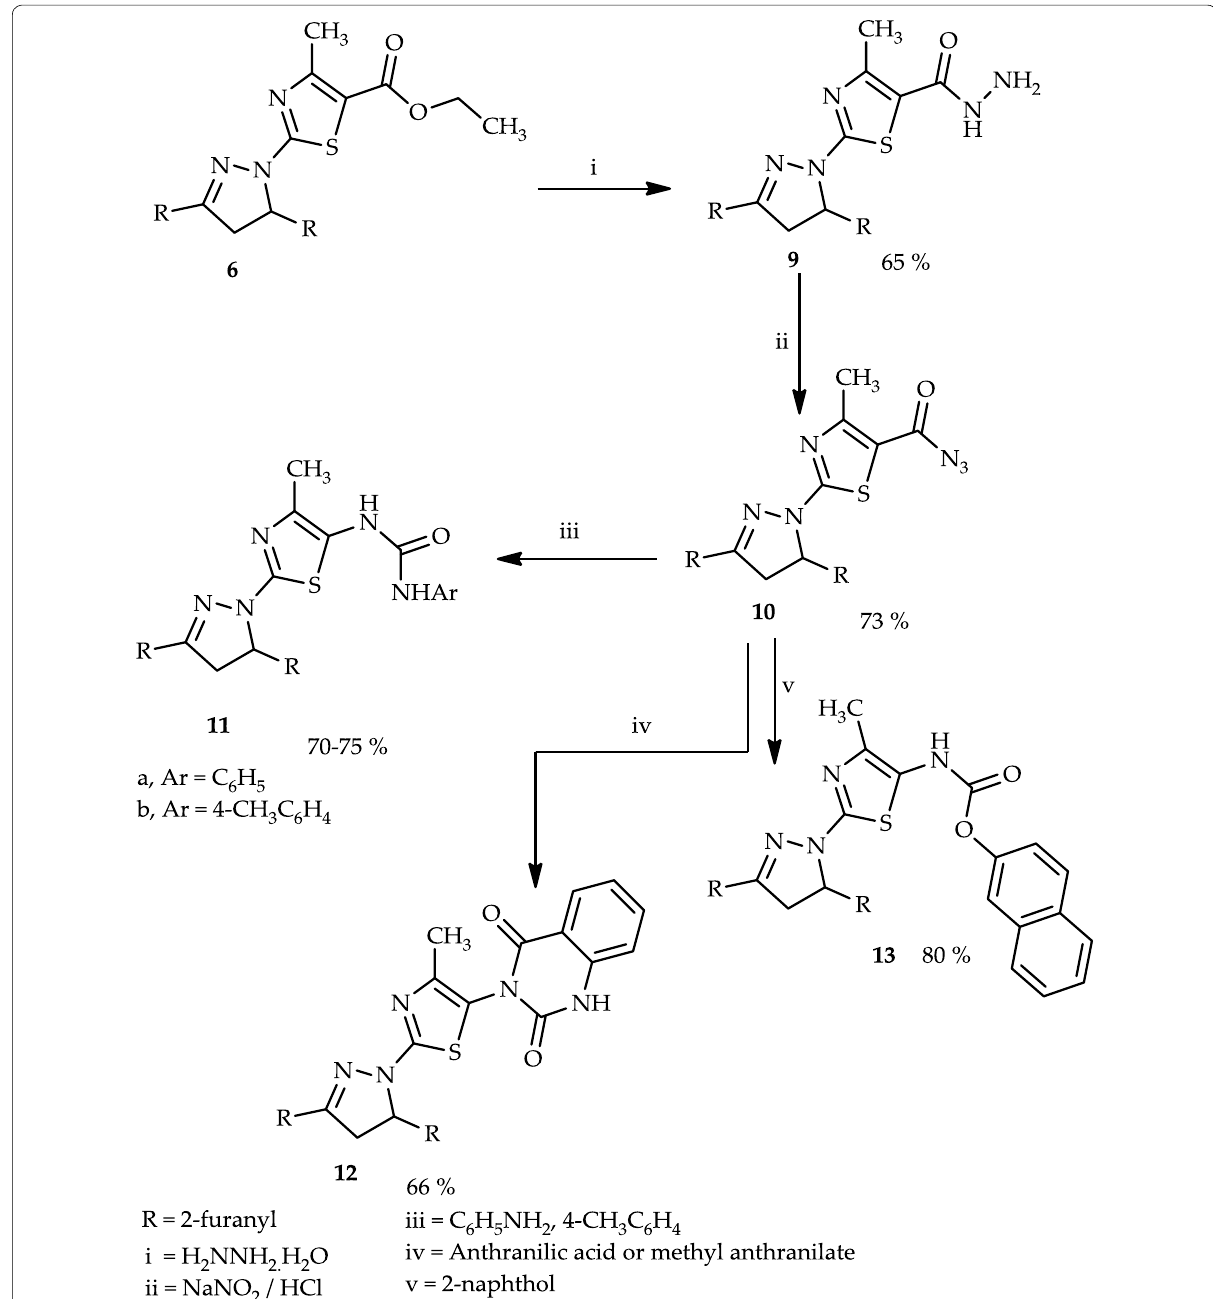
Scheme 3 Synthesis of thiazole derivatives ( 9 ), ( 10 ), urea derivatives ( 11a and 11b ), quinazoline 12 , and β‑naphthyl carbamate ( 13